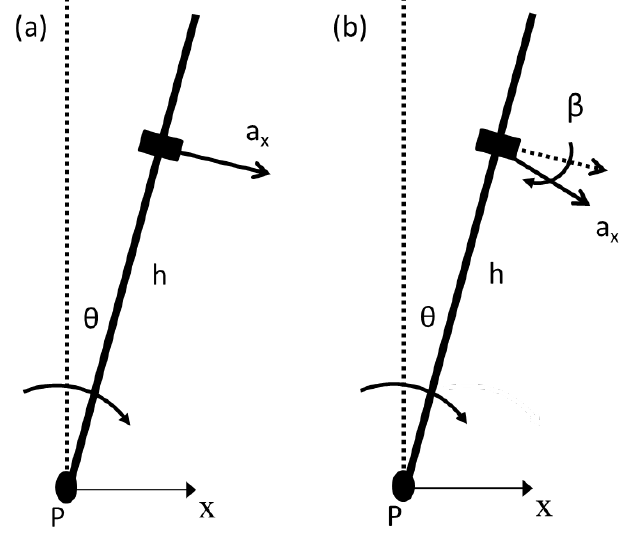
Figure 1. ( a ) IP model and ( b ) IP model with misalignment of the sensitive axis of the